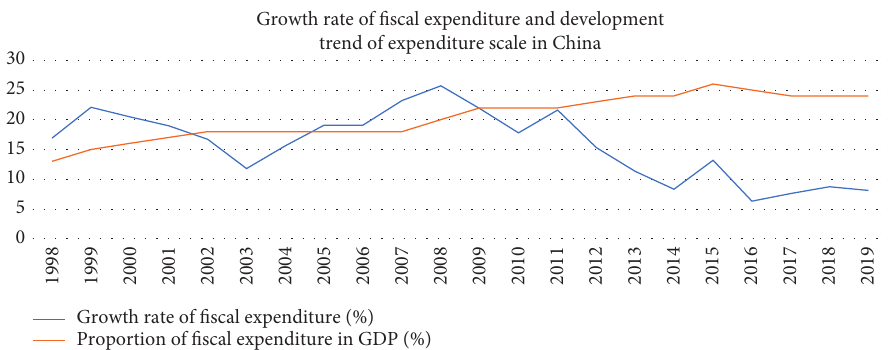
Growth rate of fiscal expenditure (%) Proportion of fiscal expenditure in GDP (%) Figure 2: Growth rate of fiscal expenditure and development trend of expenditure scale in China from 1998 to 2019.